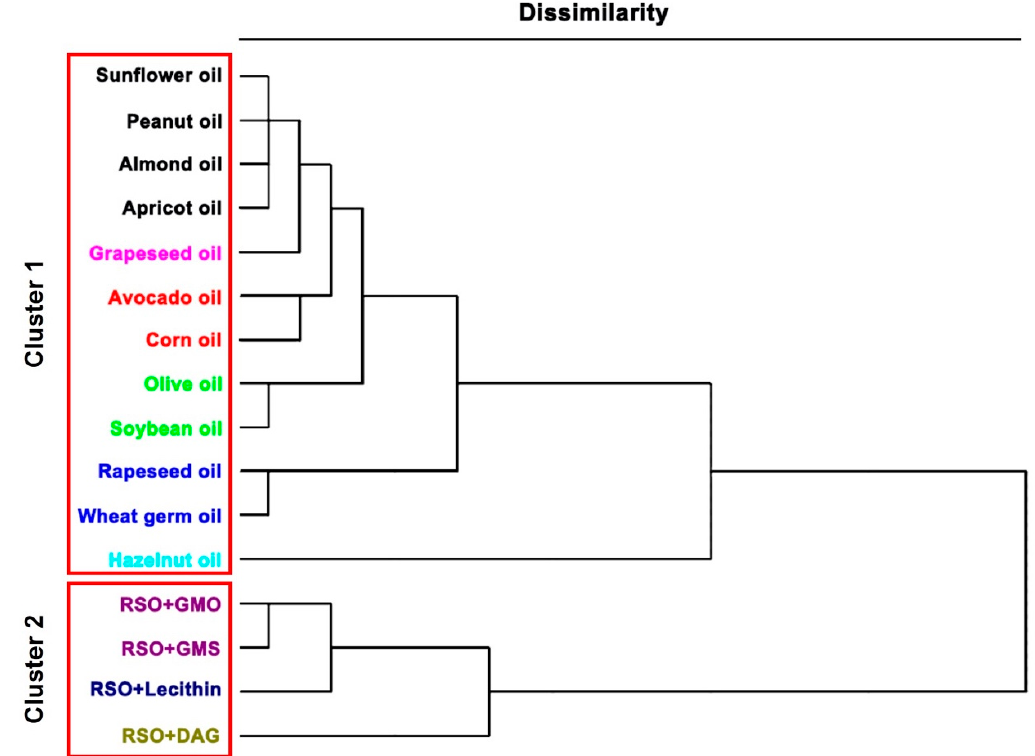
Figure 6. Dendrogram resulting from Ward’s hierarchical cluster analysis corresponding to the dissolving power of oily solvents in terms of volatile and non-volatile bioactive compounds extracted.